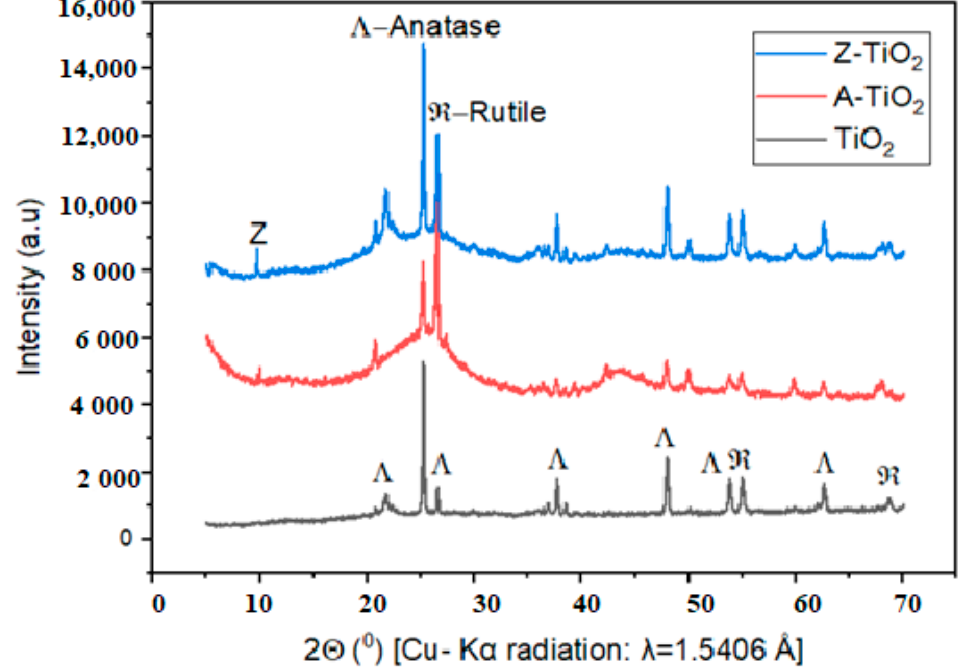
Figure 1. XRD pattern of TiO 2 (black), A–TiO 2 (red) and Z–TiO 2 (blue); Λ —anatase, and ℜ — rutile.